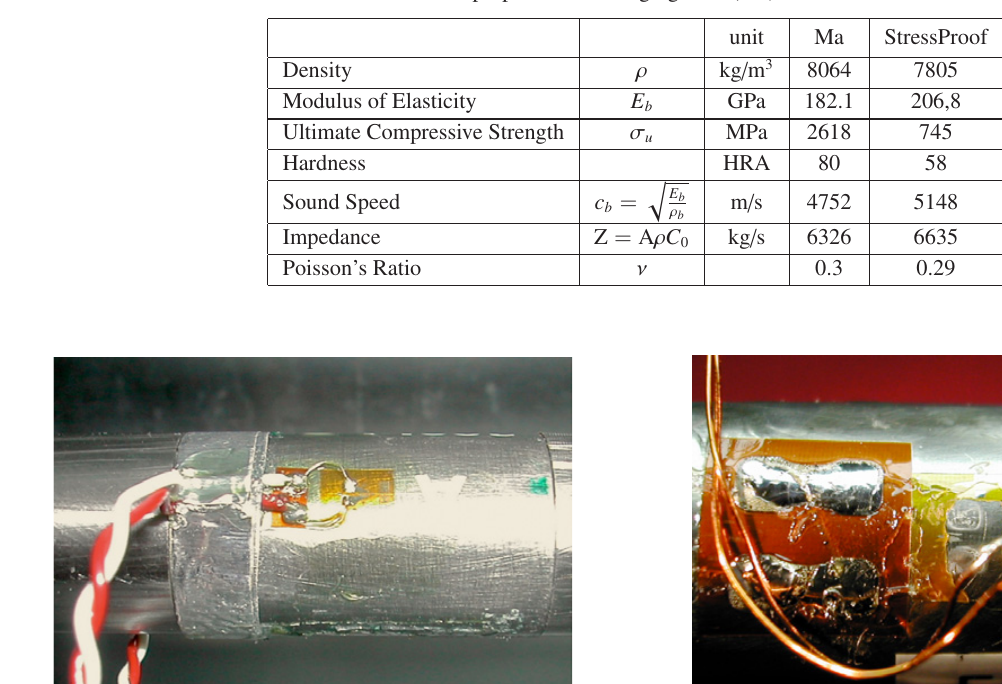
Table 1. Mechanical properties of Maraging steel (Ma) and Stress-Proof steel.